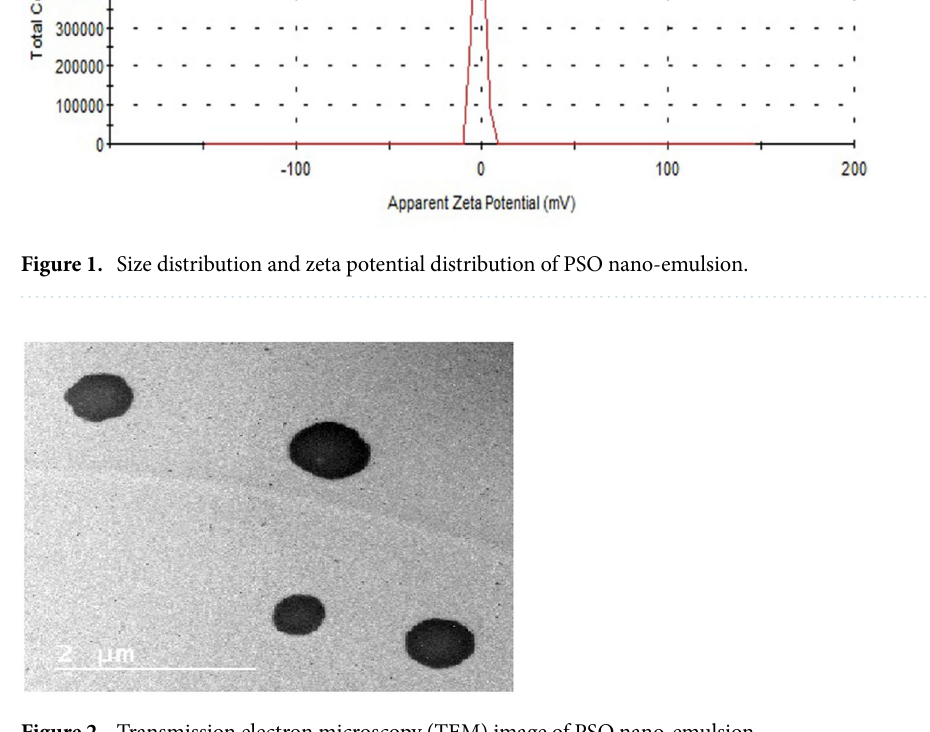
Figure 2. Transmission electron microscopy (TEM) image of PSO